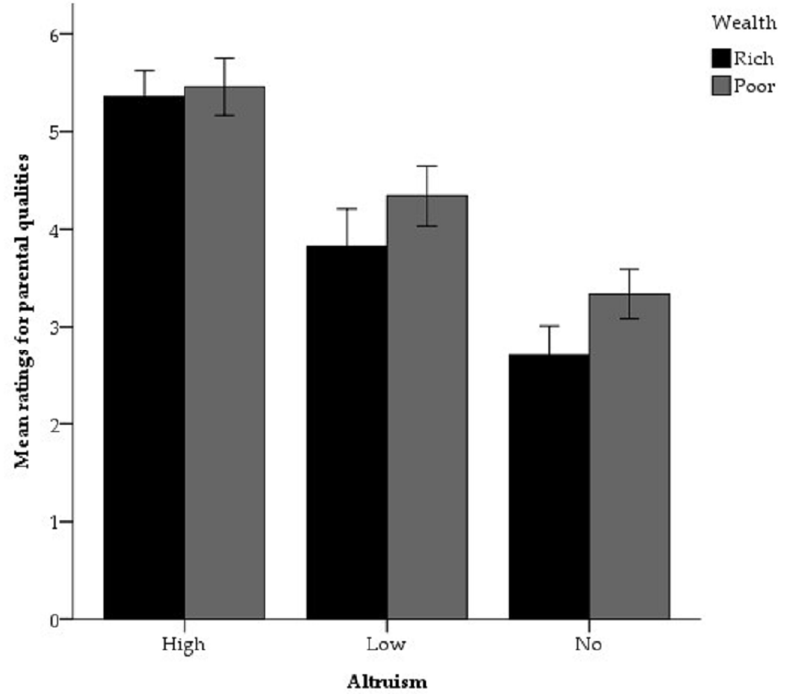
Figure 4. Mean ratings of parental quality in the high-cost, low-cost and no altruism conditions when the actor was described as rich compared to when he was described as poor (error bars represent 95% confidence